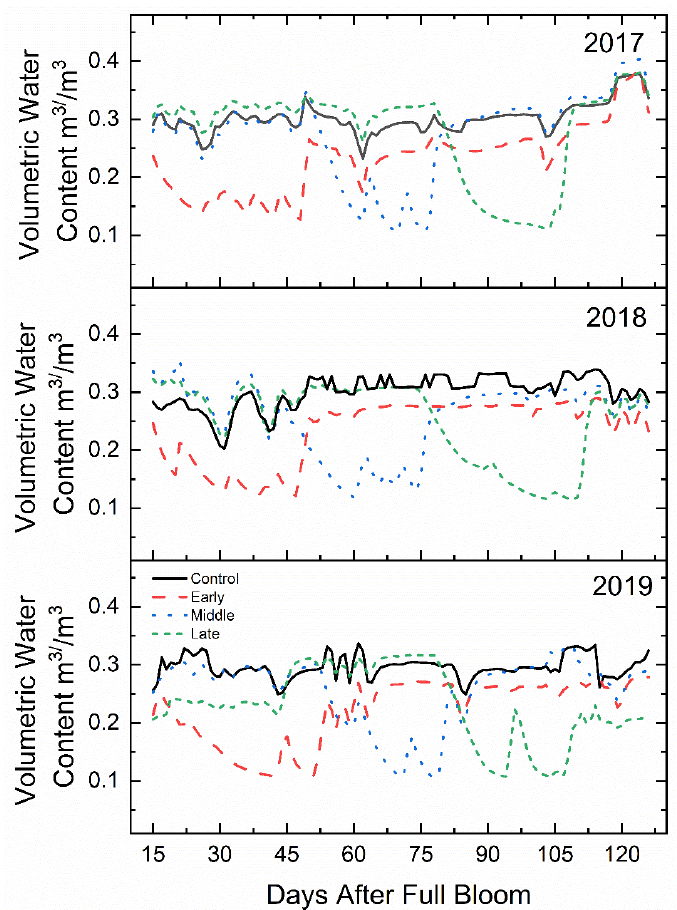
Figure 1. Mean soil volumetric water content (m 3 m − 3 ) ( n = 3) of ‘Honeycrisp’ apple under deficit irrigation from full bloom to harvest in 2017 (bottom), 2018 (middle), 2019 (top). Four treatments were established including a well-watered control (line), early-season deficit (16–45 days after full bloom [DAFB]; dashes), mid-season deficit (46–75; dots), and late-season deficit (76–105 DAFB; small dashes).